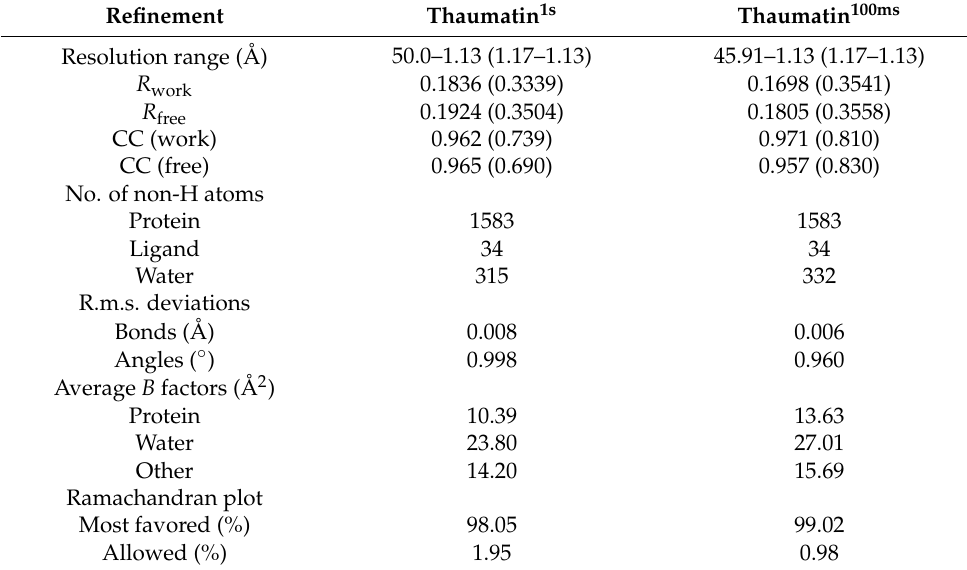
Table 2. Data refinement